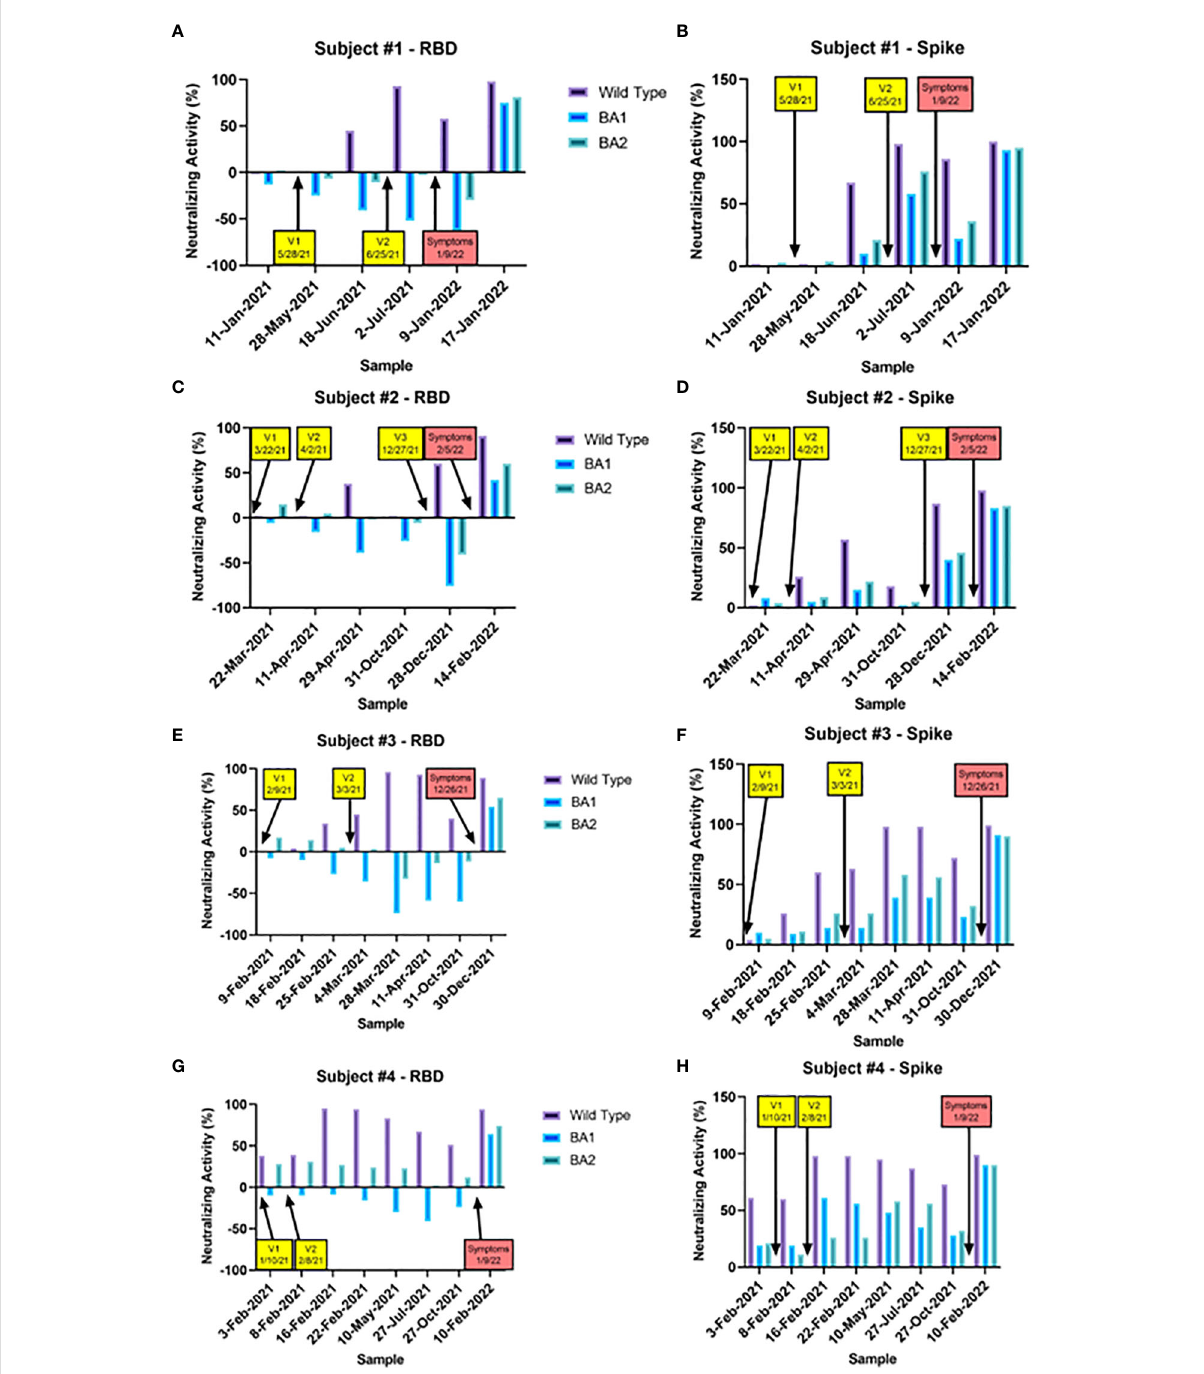
FIGURE 4 Nabs for RBD and Spike WT, BA.1, and BA.2 are shown for a set of samples taken from four representative vaccinated subjects who experienced a breakthrough infection during the omicron era. The timing of each vaccination (yellow boxes) and the onset of symptoms (red boxes) are indicated with arrows. In all four cases, vaccination robustly increased WT Nabs to RBD and Spike to a similar degree. BA.1 and BA.2 Nabs were not increased at all by vaccination (in fact were negative) when the RBD antigen was used (A, C, E, G) , and increased only slightly with the spike antigen (B, D, F, H) . In contrast, omicron breakthroughs led to increases in Nabs for WT, BA.1, and BA.2 with both RBD and Spike. In all four cases, RBD BA.1 and BA.2 Nabs were the lowest at the time of the breakthrough, suggesting they were they best indicator of infection